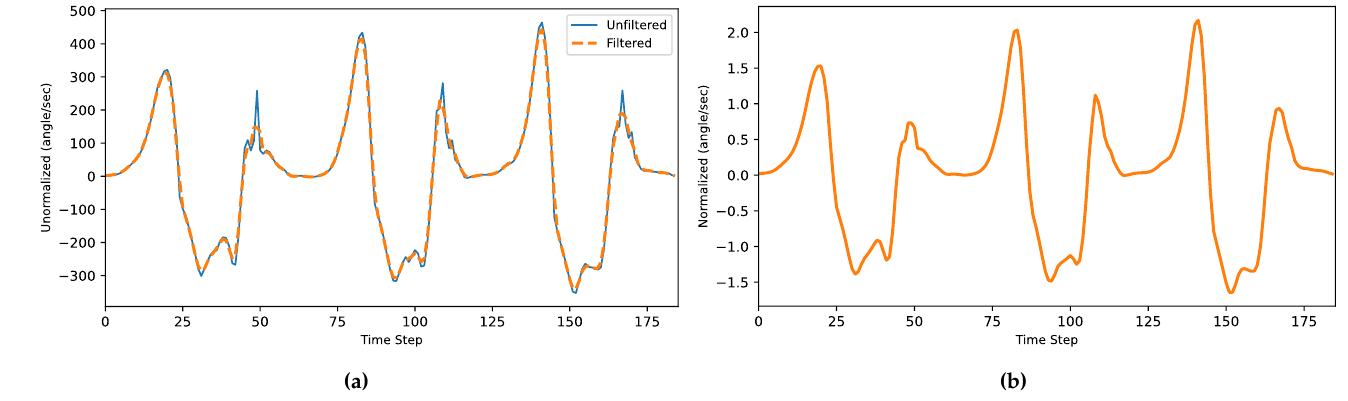
Figure 2. ( a ) Filtered Data. ( b ) Normalized Filtered Data (moving average window = 3).